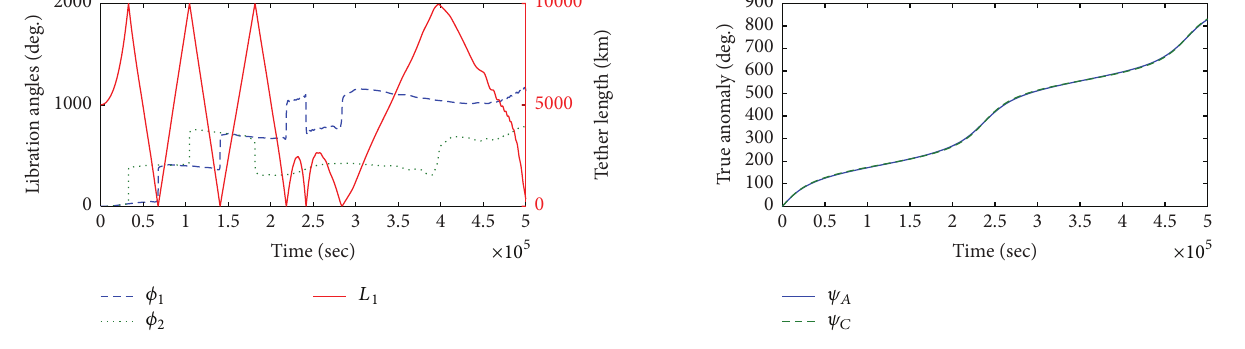
Figure 6: Libration angles and tether length 𝐿 1 by the formulations based on point 𝐴 .